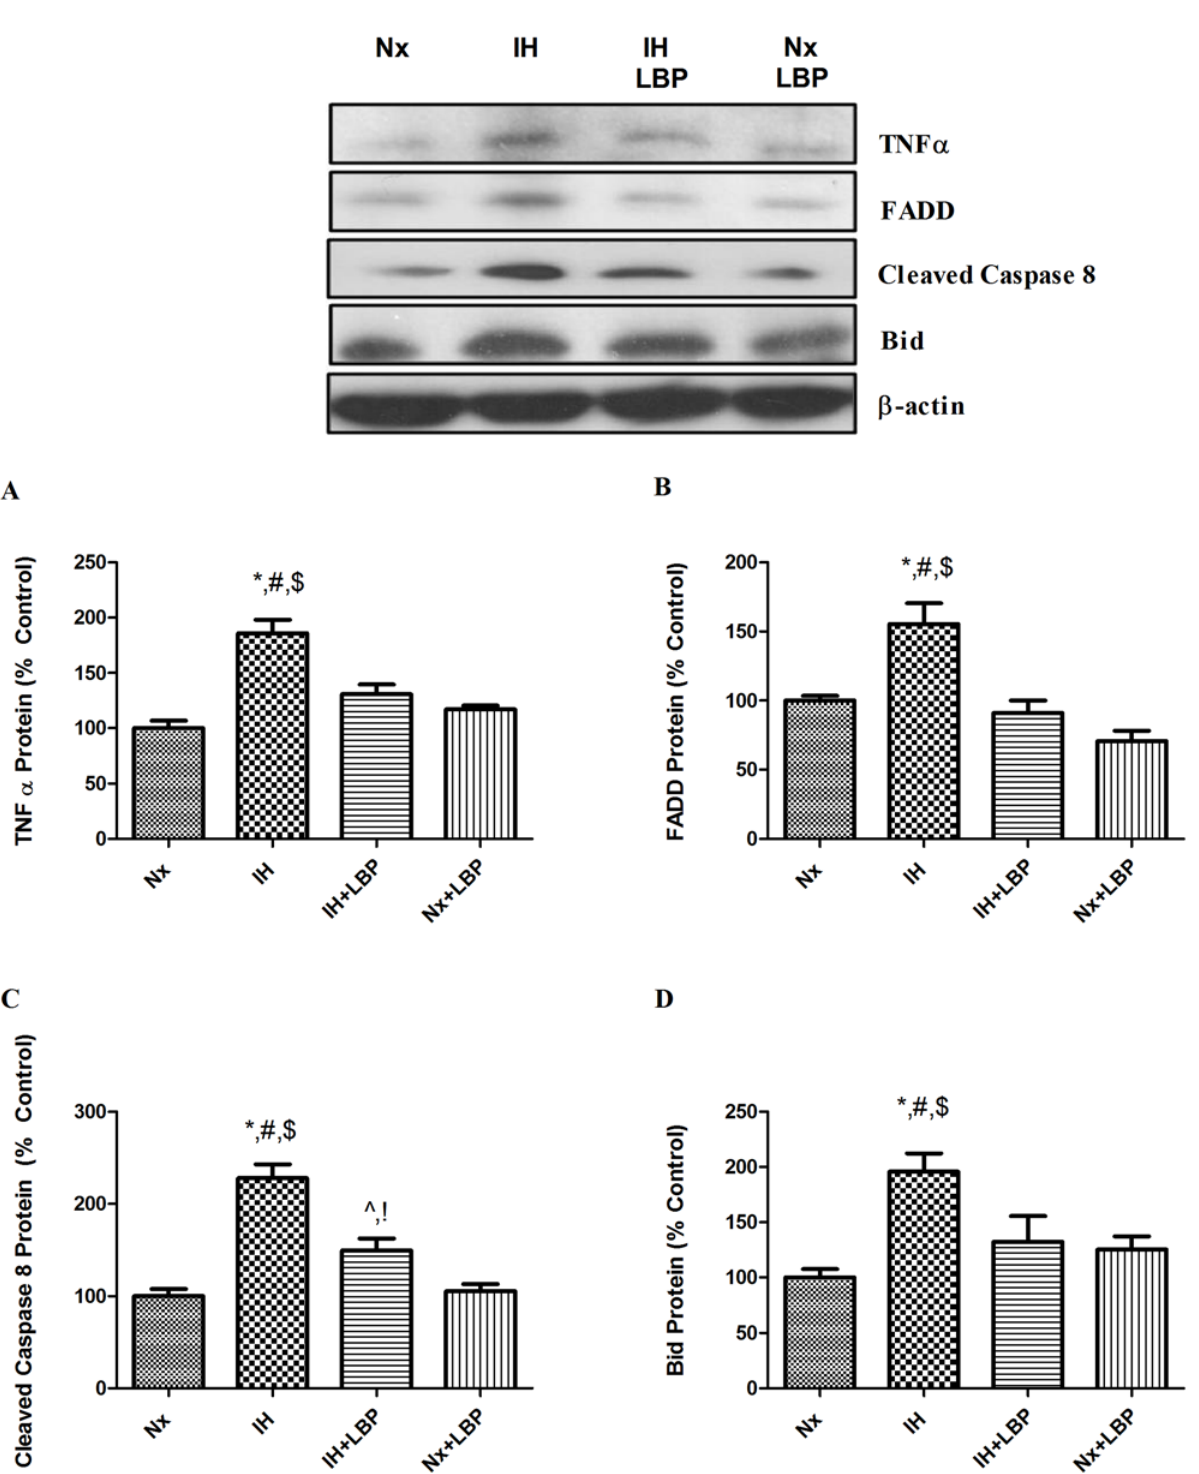
Fig 4. LBP ameliorated extrinsic caspase-dependent apoptosis induced by CIH treatment. Levels of the protein expression (upper panel) of (A) TNF α , (B) FADD, (C) cleaved caspase 8 and (D) Bid in the hippocampus of the normoxic (Nx) or hypoxic (IH) groups; LBP-treated hypoxic (IH+LBP) or normoxic (Nx+LBP) groups are summarized. β -actin was an internal control. Data are mean ± SEM (n = 6 – 8). For TNF α , FADD and Bid, * p < 0.05 when compared with Nx, # p < 0.05 when compared with IH+LBP, $ p < 0.05 when compared with Nx+LBP groups. For cleaved caspase 8, * p < 0.05 when compared with Nx, # p < 0.05 when compared with IH+LBP, $ p < 0.05 when compared with Nx+LBP groups, ^ p < 0.05 when compared with Nx, ! p < 0.05 when compared with